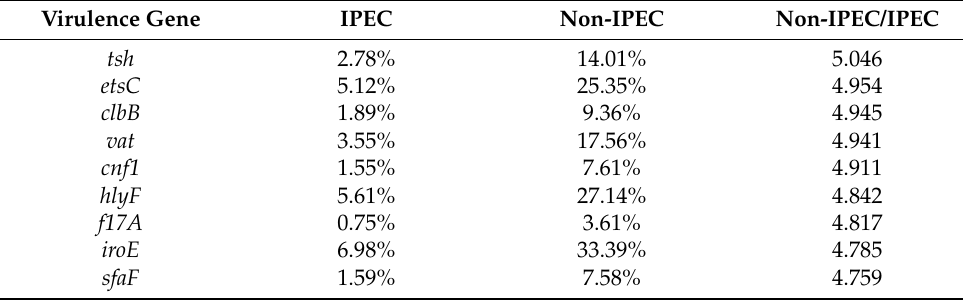
Table 2. Virulence genes with >2-fold greater representation in the non-IPEC